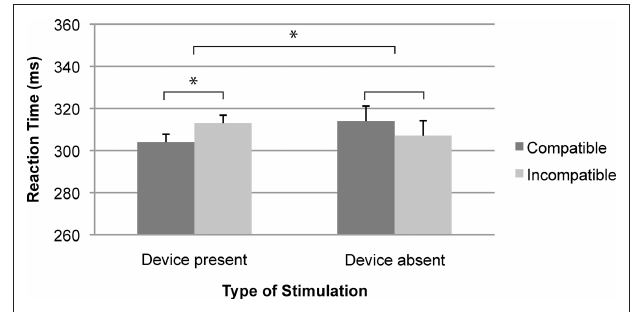
Figure 7 | Mean reaction time as a function of the type of stimulation and spatial stimulus–response compatibility. Error bars represent standard errors of the mean differences. * p